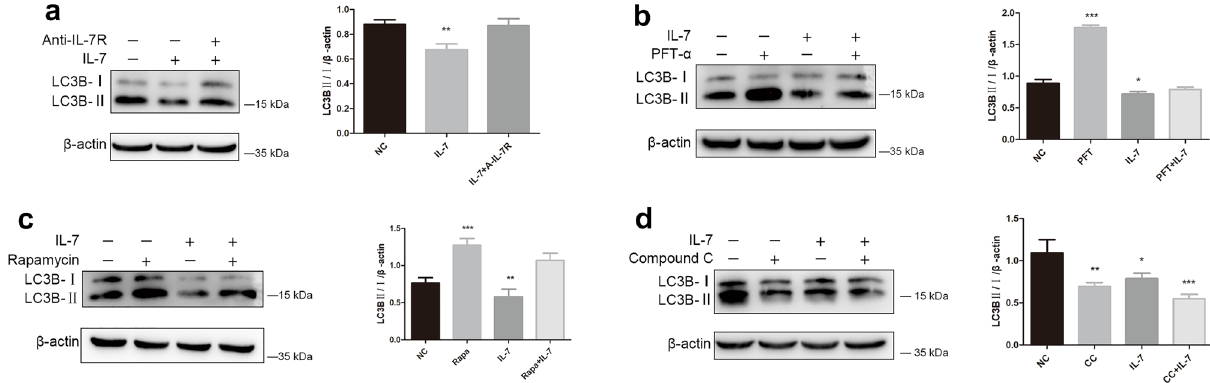
Figure 5. IL-7, PFT-α, Rapamycin, Compound C affect LC3 expression. ( a ) IL-7 down-regulate LC3 and this effect can be blunt by IL-7R. ( b ) PFT-α up-regulate the LC3 protein level. ( c ) Rapamycin increase the expression of LC3. ( d ) Compound C decrease the expression of LC3. All the bar graph expressed as Mean ± SD, n = 3. *represent for P < 0.05 versus negative control (NC). ** and *** represent for P < 0.01 versus